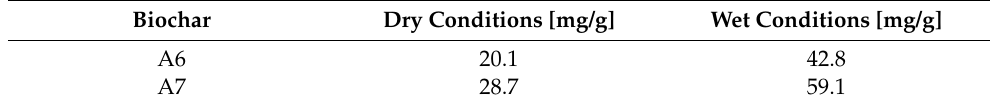
Table 3. NO 2 breakthrough capacities of A6 and A7 samples obtained.